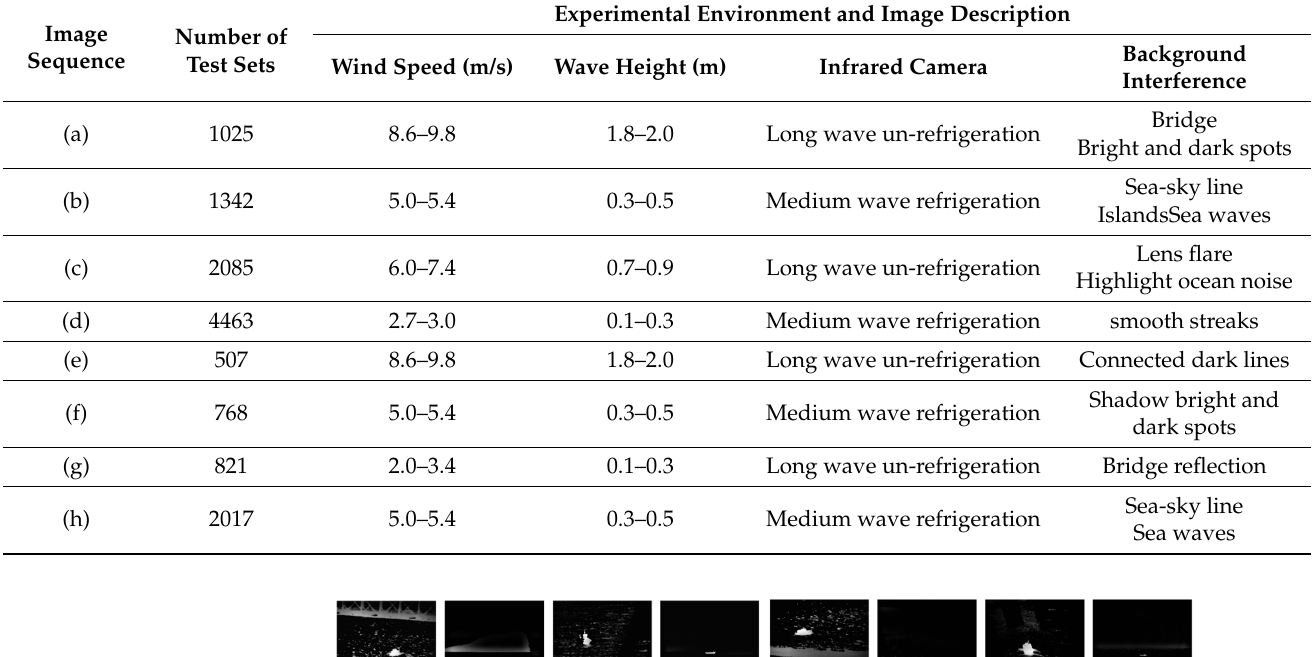
Table 1. Experimental environment and image description of each image sequence.